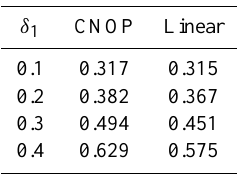
Table 2. The variations calculated by the Eq. (4) in the grassland ecosystem caused by the CNOP obtained by optimizing the Eq. (3) and linear combination of the CNOP-I and the CNOP-P obtained by optimizing the Eqs. (5) and